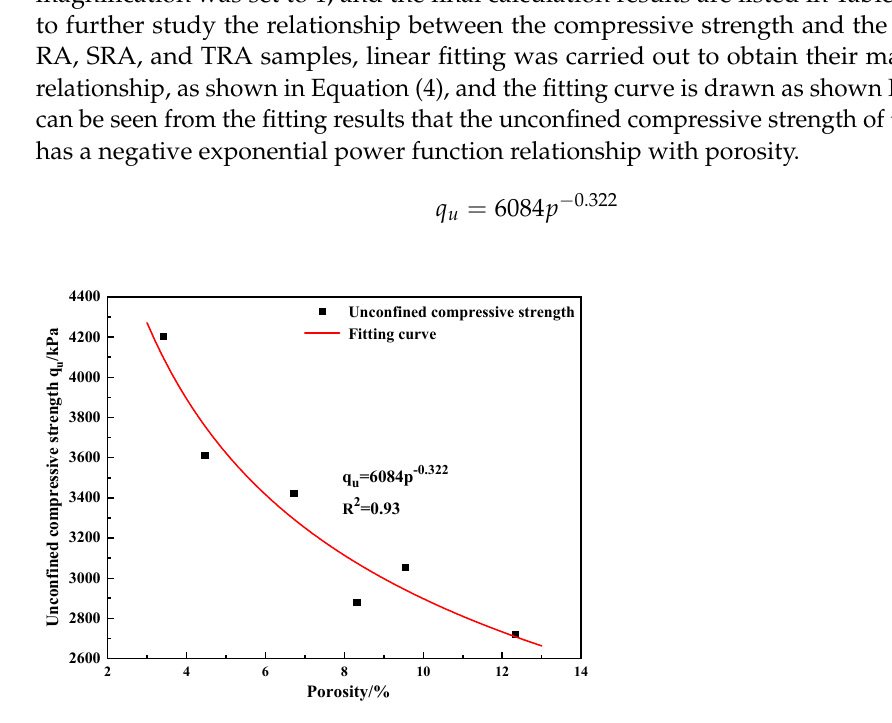
Figure 10. Fitting curve of unconfined compressive strength and porosity.